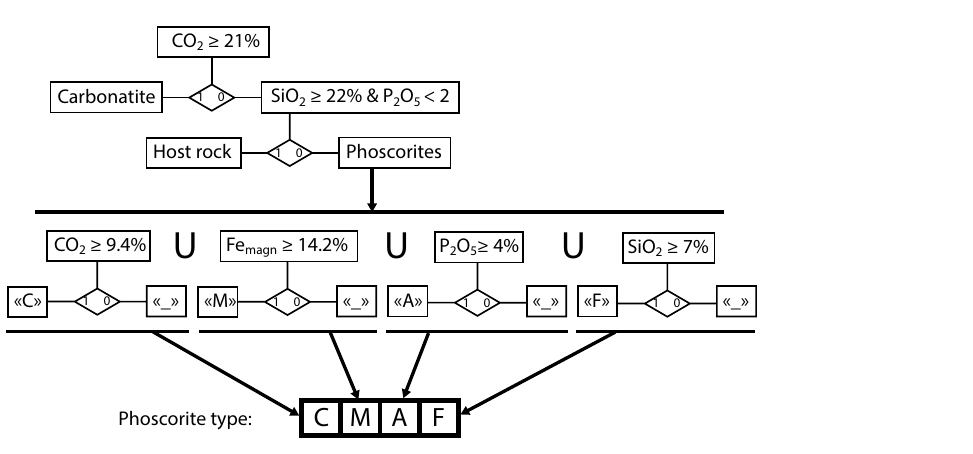
Figure 4. Flowchart of logical evaluation of a rock